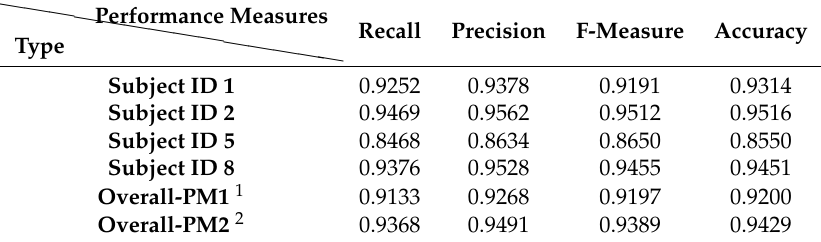
Table 8. Performance measures in the scenario of independent